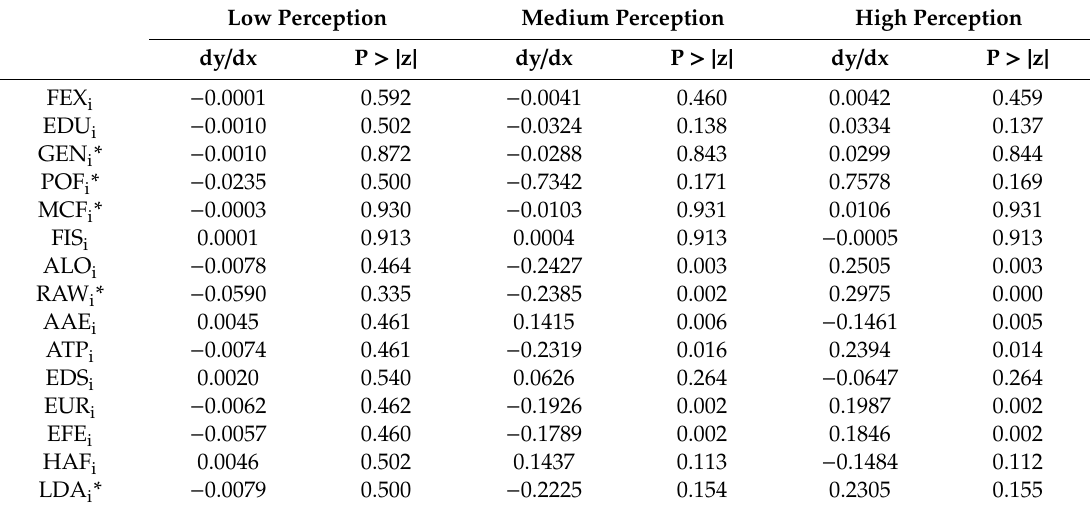
Table 9. Marginal e ff ects of ordered probit models for rainfed-farm households. Low Perception Medium